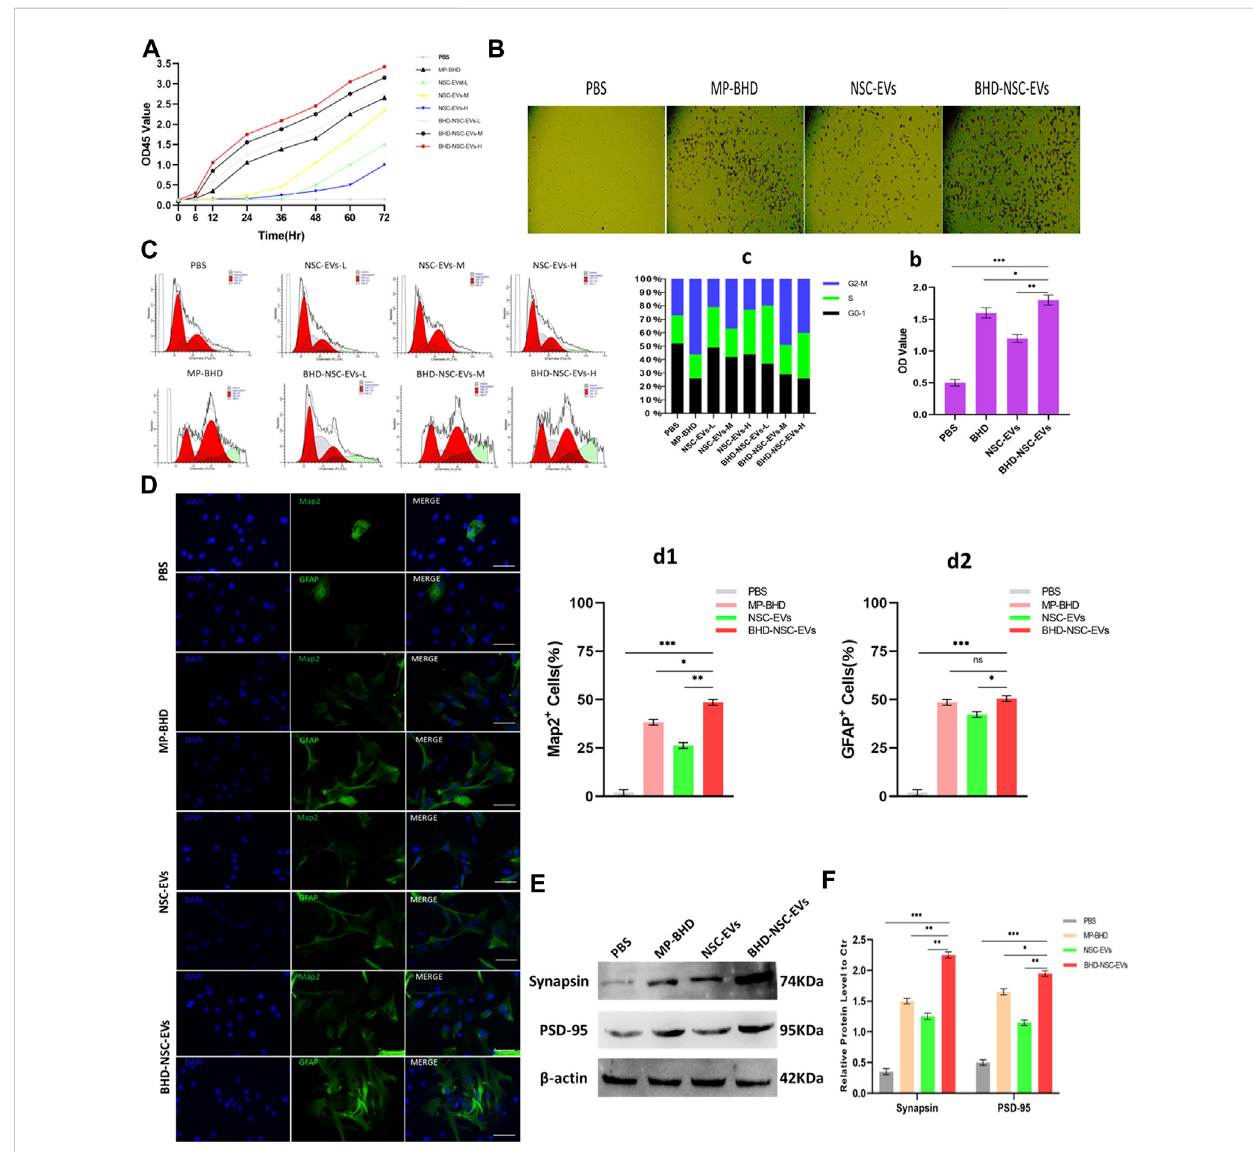
FIGURE 6 The impact of BHD-NSC-EVs on the neurogenetic activities of NSCs in vitro . (A) CCK-8 analysis was used to measure the effect of MP-BHD, NSC- EVs,BHD-NSC-EVsorPBSontheproliferationofNSCs,themeanOD45valueabsorbanceminustheblankvaluerepresentedcellproliferation.NSC-EVs andBHD-NSC-EVswereaddedinwellsfromlowtohighdosage(L,50 μ g/mL;M,100 μ g/mL,H,200 μ g/mL).( n =3/group), (B-b) Representativeimages oftranswellassayforeachtreatmentgrouptoassesstheimpactontheneurogeneticactivitiesofNSCs.* p < 0.05,** p < 0.01,*** p < 0.001,scalebar 100 μ m in panel. (C-c) Flow cytometry of Cell cycle analysis was run to determine the effect of EVs from different dosage or MP-BHD or PBS on progression of NSC cell cycle stained with propidium iodide. EVs dosage: L, 7.5 μ g/mL; M, 15 μ g/mL, H, 30 μ g/mL ( n = 5/group). (D-d) Representative fl uorescence stainingwith Map2 (green)orGFAP (green)and DAPI(blue) revealeddifferentiation into neuron andglial cellsofNSCs treatedwith different inductions.( n =5/group),* p < 0.05,** p < 0.01,*** p < 0.001,scalebar100 μ minpanel (E-e) Westernblotanalysisoftheexpressionofmarkerofsynapse- related factor Synapsin in differentiated NSCs. ( n = 5/group), * p < 0.05, ** p < 0.01, *** p < 0.001. All data are from three independent experiments and are presented as mean ± s.e.m,two-sided Student ’ s t -tests were used for comparisons (A,b,c,d1,d2,e)